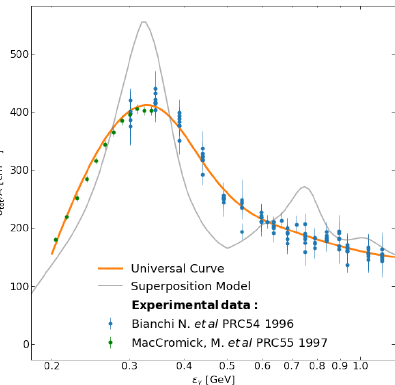
Figure 5. Cross-section over mass number as a function of the photon-energy in the nucleus rest frame. The data points show measurements of di ff erent isotopes, suggesting a univer- sal cross-section behaviour for all nuclei heavier than protons (orange curve). The gray curve represents the superposition model, which approximates the nucleus’ cross-section by σ A γ = Z N σ σ p γ + n γ with the proton and neutron cross-sections A A σ n γ . Figure taken from